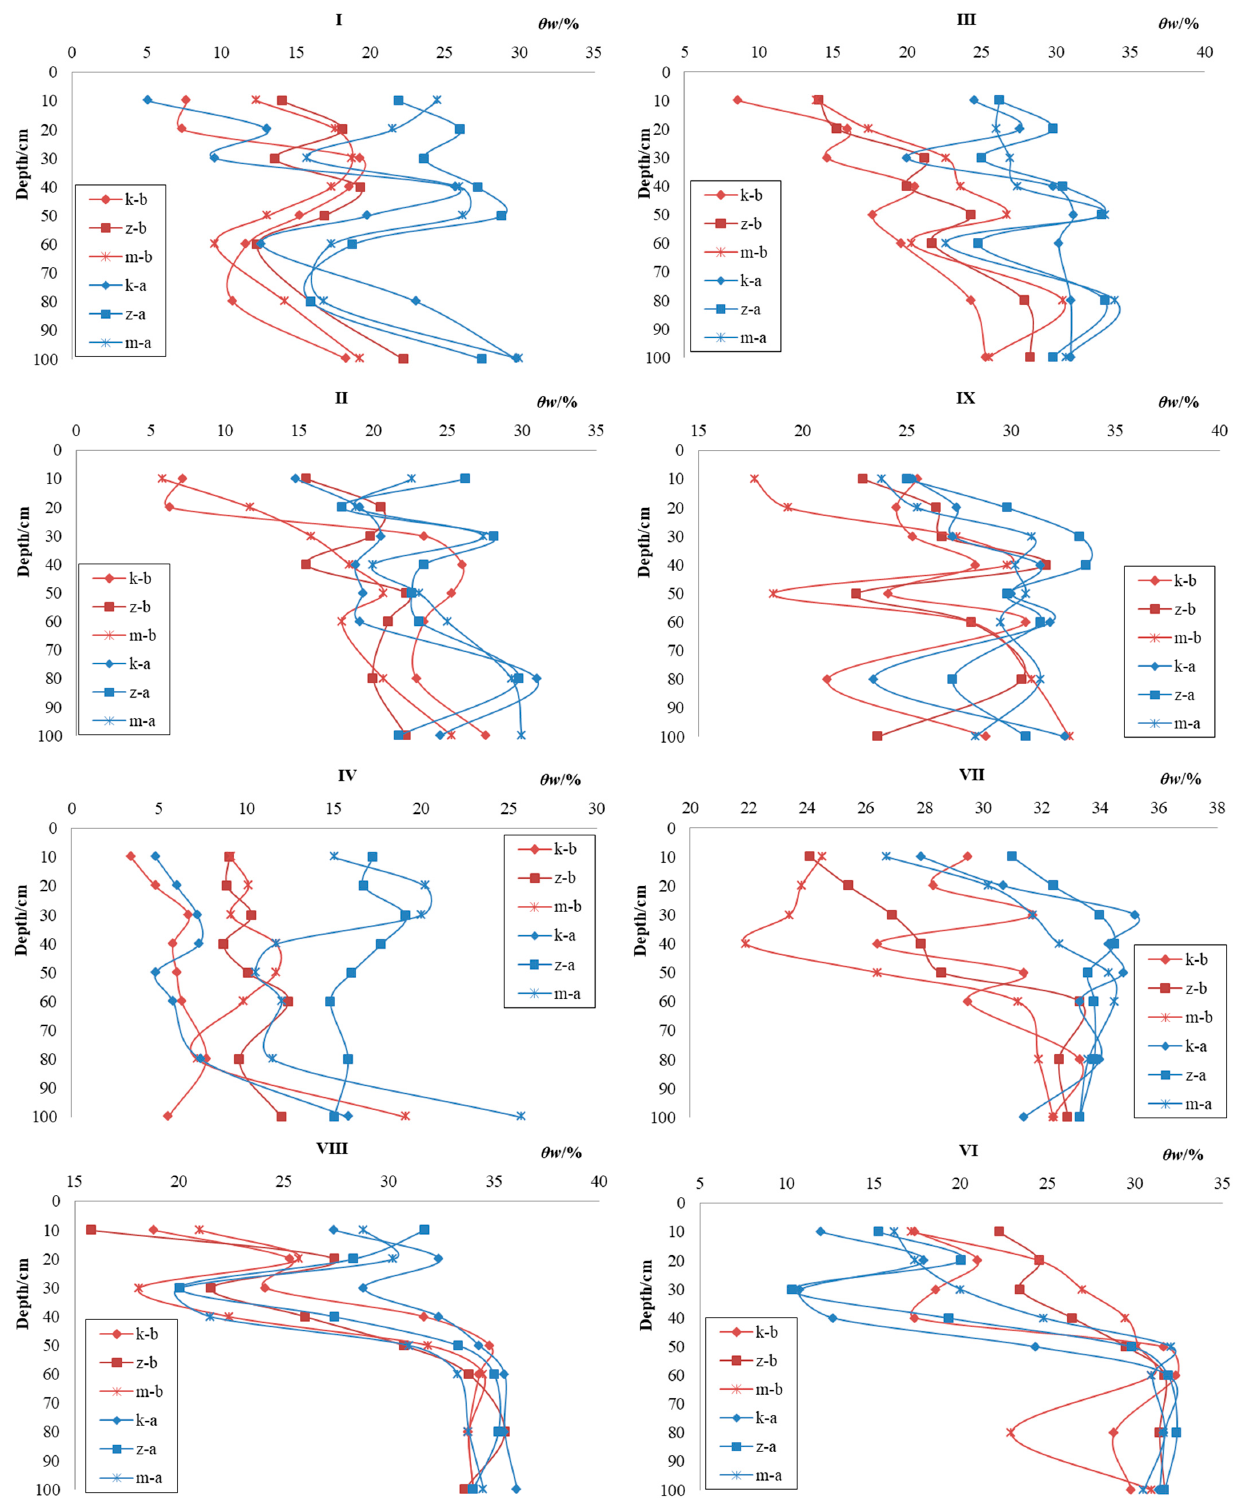
Figure 2. Water distribution of soil profile in each irrigation scenario before and after the fourth irrigation (The arrangement of each scenario in the figure decreases successively according to the amount of irrigation). Note: In the figure, I represents the name of the scenario, k-wide row, z-narrow row, m -intermembrane, b- before irrigation, a- after irrigation. Therefore, k-b represents the water distribution in soil profile before wide-row irrigation.